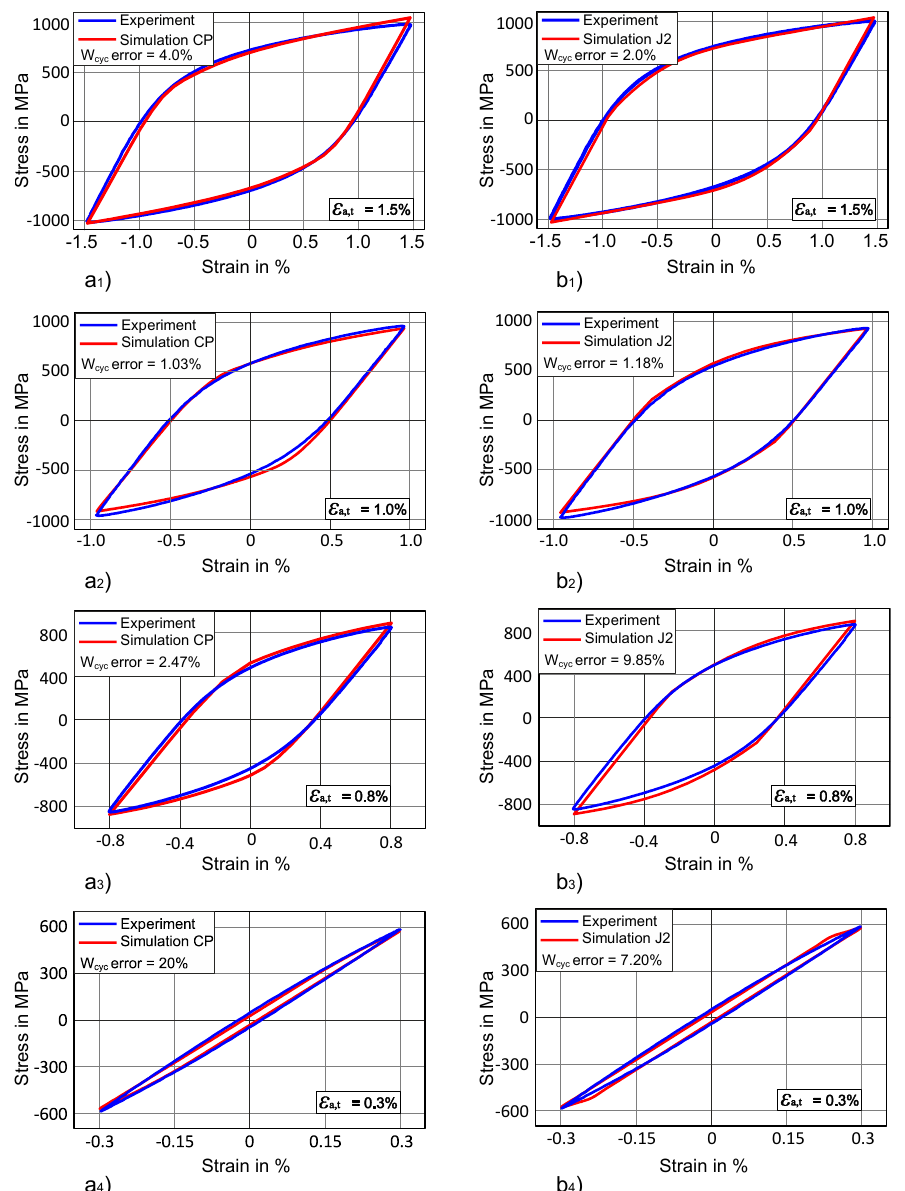
Figure 10. Optimised stress-strain hysteresis for CP (left side) and for J2 plasticity (right side) at total-strain amplitude of ( a 1 , b 1 ) 1.5%, ( a 2 , b 2 ) 1.0%, ( a 3 , b 3 ) 0.8%, and ( a 4 , b 4 ) 0.3% respectively.